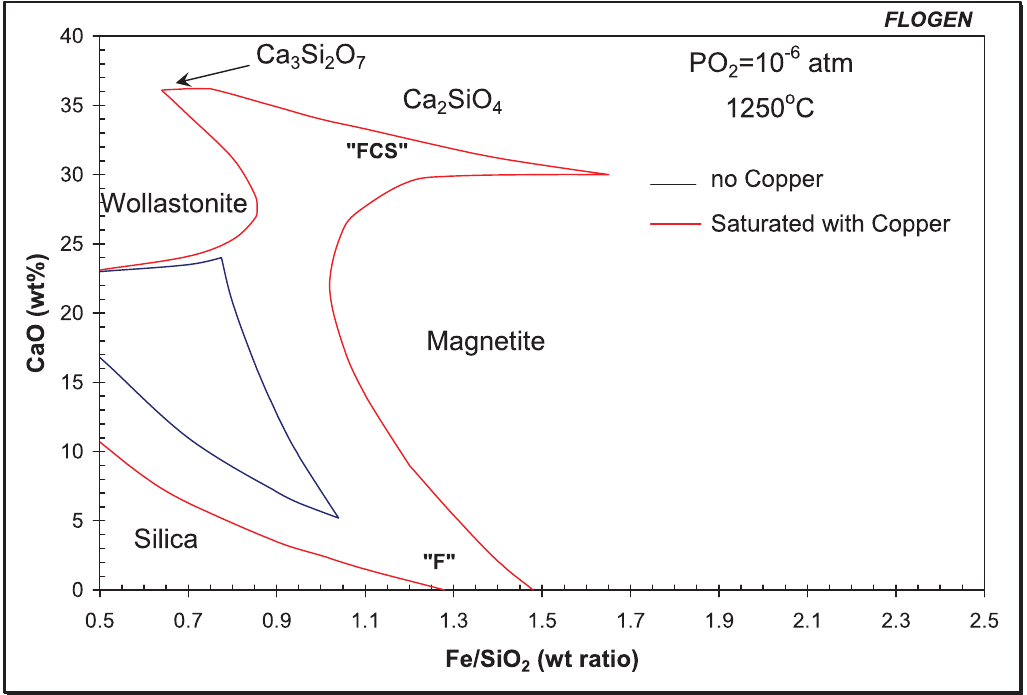
Figure 12. Effect of copper saturation of the liquid region of fayalite (“F”) and ferrous calcium silicate (“FCS”) slags calcium in FeO x -SiO 2 -CaO-Cu 2 O system.